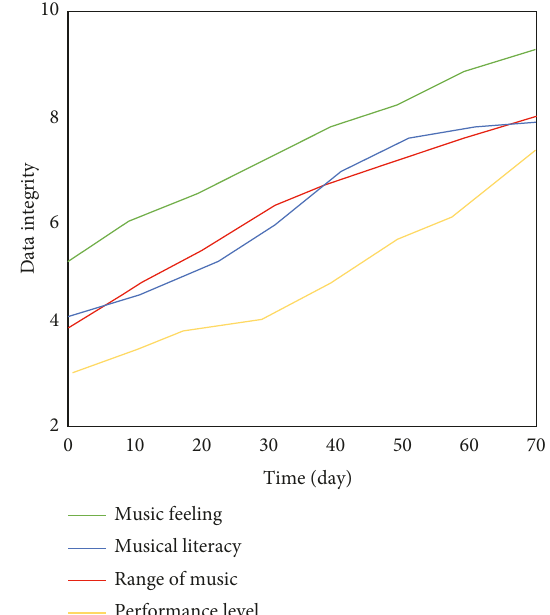
Figure 7: The relationship between the students’ music scores and days under Bayesian model data